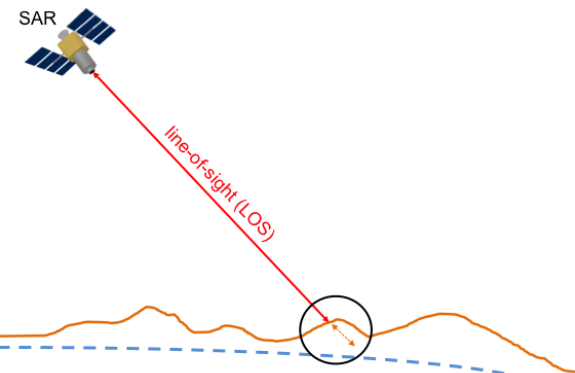
Figure 1. Measurement direction of differential